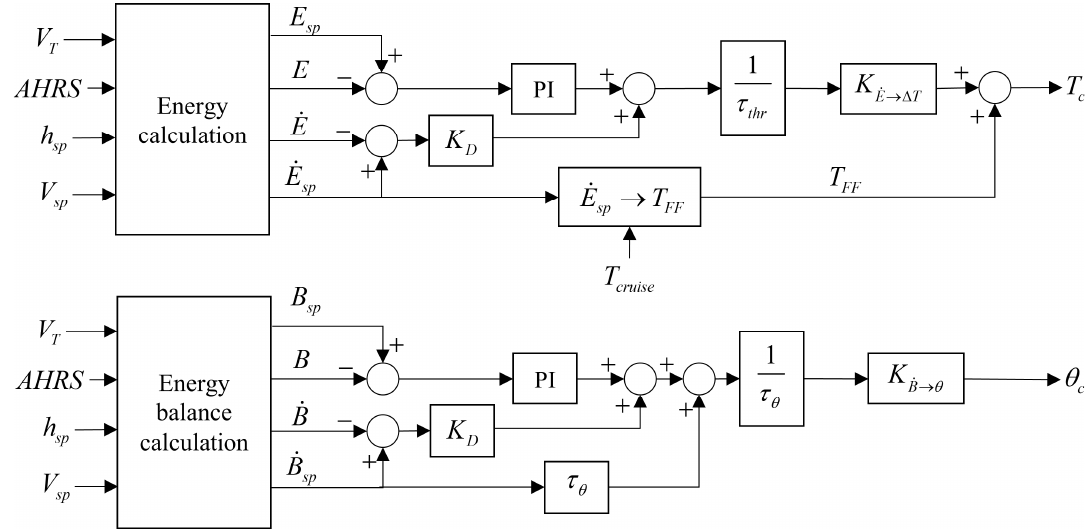
Figure 9. The schematic diagram of the Total Energy Control System (TECS).